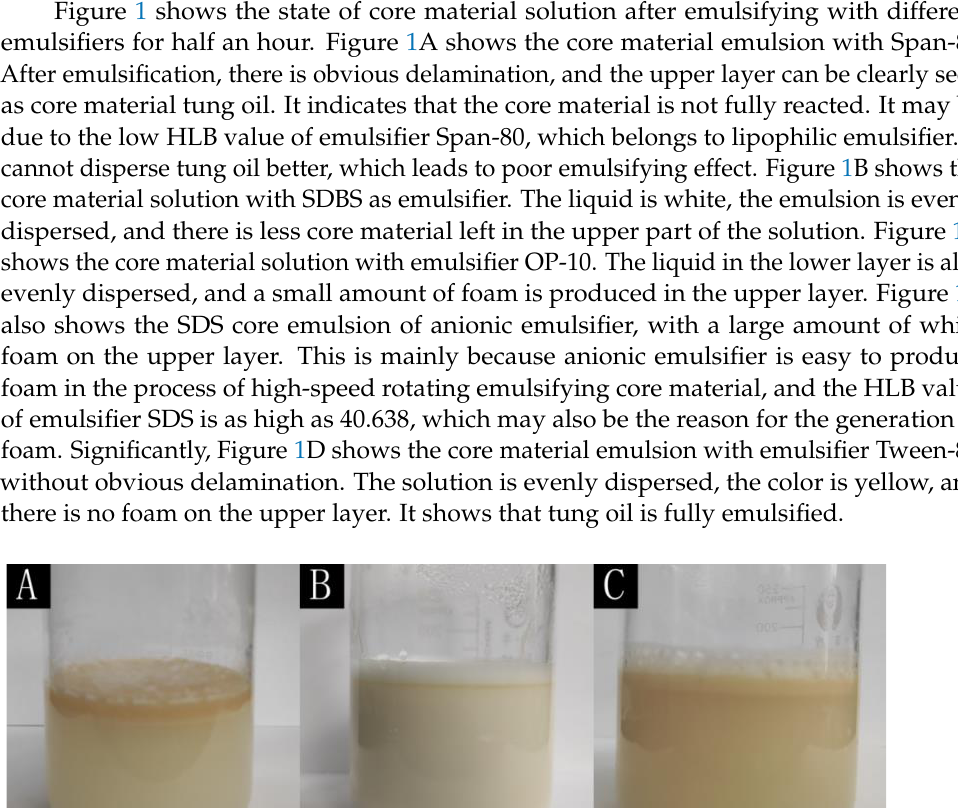
6 of 16 ticity changes from yellow to blue, positive value indicates that the chromaticity is yel- low; on the contrary, it is blue. The c is color saturation. Through the test of two places of the paint film, two sets of data are tested, which are ΔL , Δa and Δb , respectively. The calculation Formula (2) is as follows [37].] ΔE = [( ΔL ) 2 + ( Δa ) 2 + ( Δb ) 2 ] 1/2 (2) Gloss test of paint film: LS195 gloss meter (Shenzhen Linshang Technology Co., Ltd., Shenzhen, China) is used to measure the gloss of paint film at 20°, 60° and 85°. Self-repair performance test of paint film: A micro crack blade is respectively marked on the paint film. The size of the micro crack was observed by optical micro- scope. After the paint film is placed flat at room temperature for five days, the size of the same crack is observed with an optical microscope. The self-repair performance of the paint film is explored by observing the change in crack size twice. All the above tests were carried out four times with an error of less than 5%.